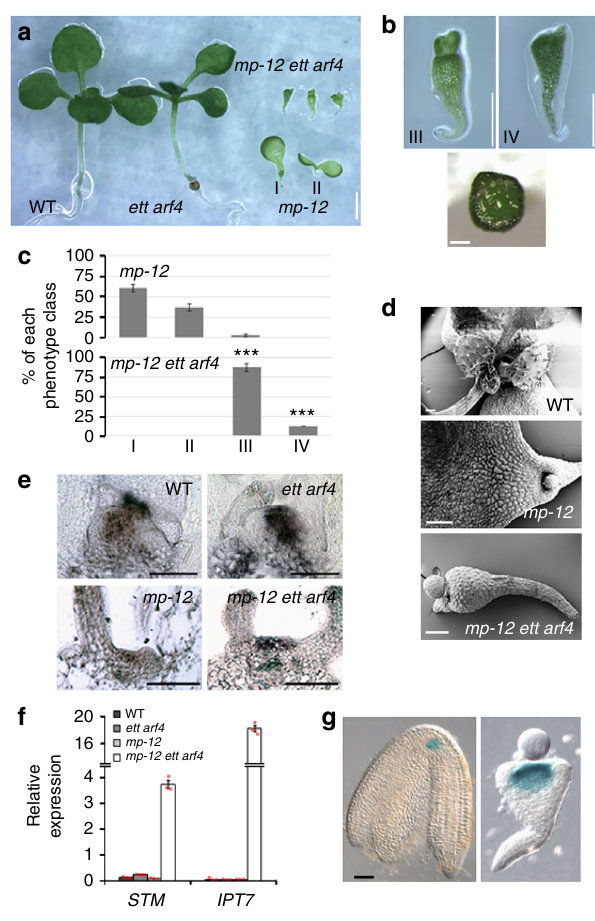
Fig. 2 ETT and ARF4 act in a pathway parallel to MP. a Phenotypes